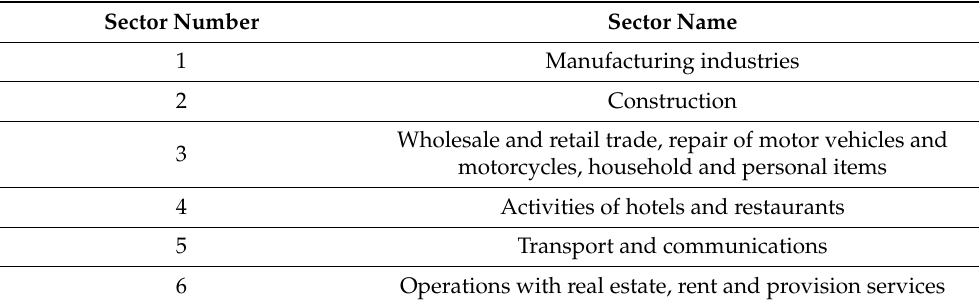
Table 1. Sectors of the economy of a single-industry town. Sector Number